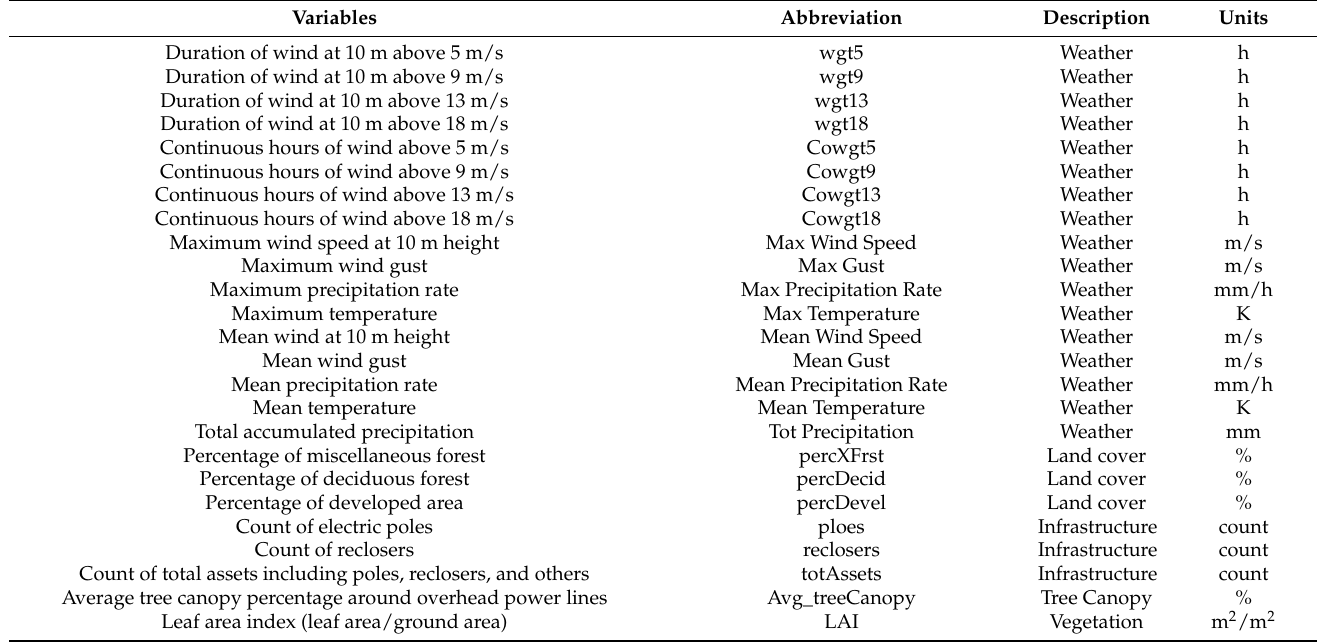
Table A1. Explanatory variables included in the